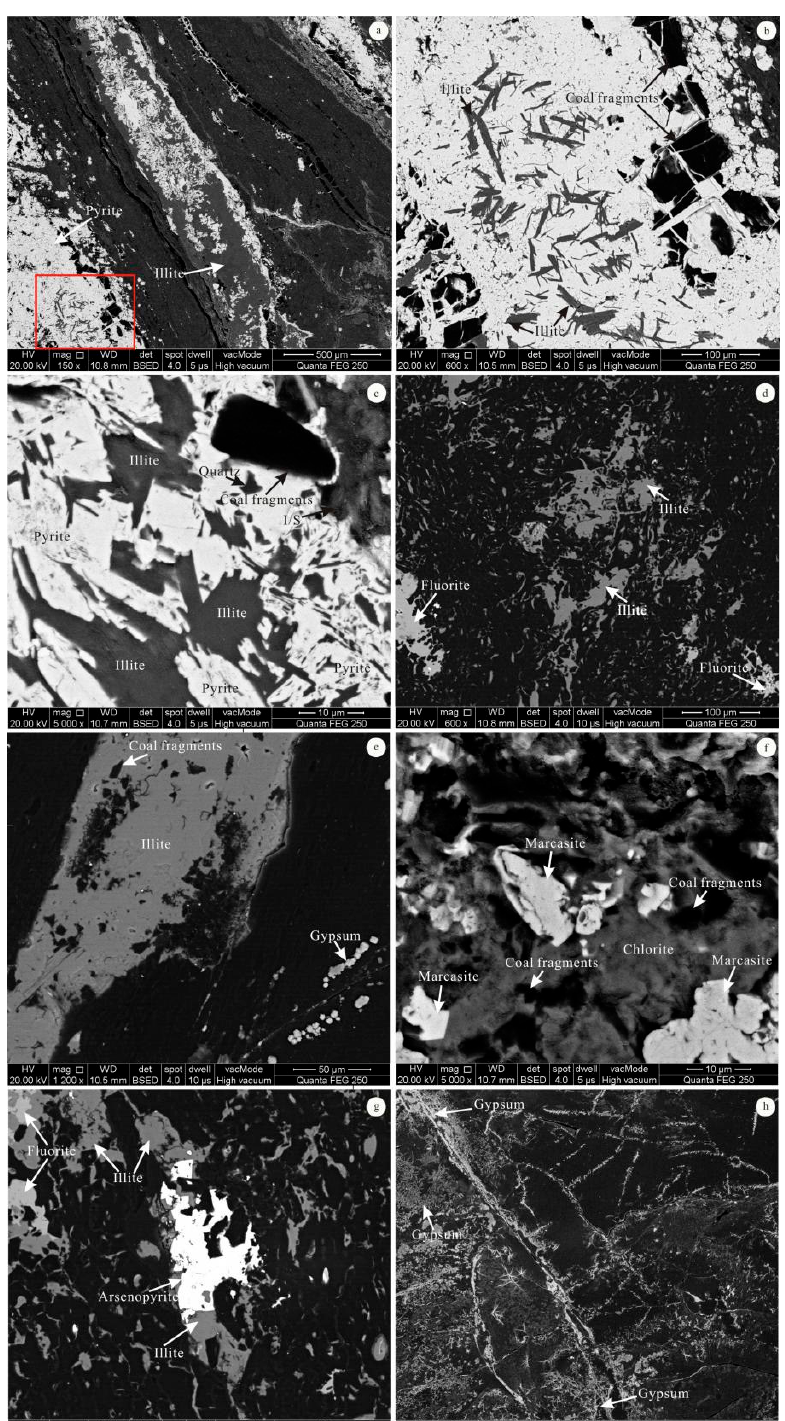
Figure 6. SEM back-scattered electron images of illite, chlorite, I/S, and pyrite in 12U and 12L Coals. ( a ) Fracture-filling pyrite and illite, and some illite and coal fragments distributed in the fracture-filling pyrite in sample 12L-1; ( b ) enlargement of the red square in ( a ); ( c ) fracture-filling pyrite and I/S, and some illite and coal fragments distributed in the pyrite in sample 12L-1; ( d ) vesicle-filling illite and fluorite in sample 12L-2; ( e ) fracture-filling illite in sample 12L-2; ( f ) vesicle- and fracture-filling chlorite, and some coal fragments and marcasite distributed in the chlorite in sample 12U-2; ( g ) vesicle- and fracture-filling illite and arsenopyrite and vesicle-filling fluorite and cavities of illite filled by fluorite in sample 12L-2; and ( h ) gypsum mainly distributed along fractures in sample 12L-2.